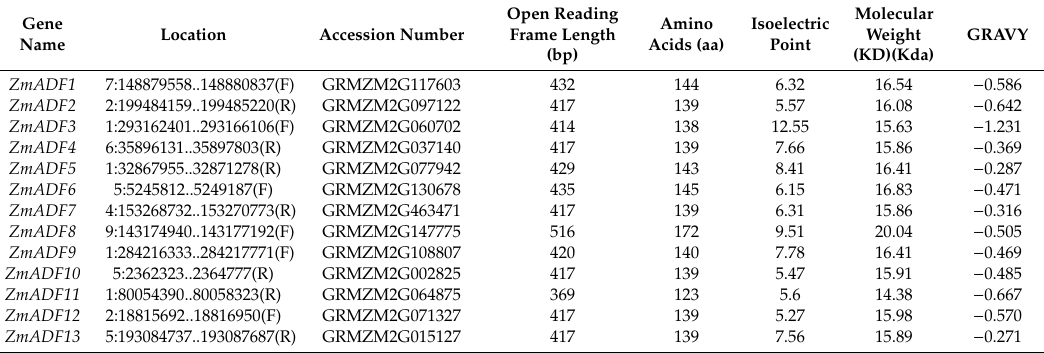
Table 1. Detailed information of all actin-depolymerizing factor (ADF) family genes identified in the maize